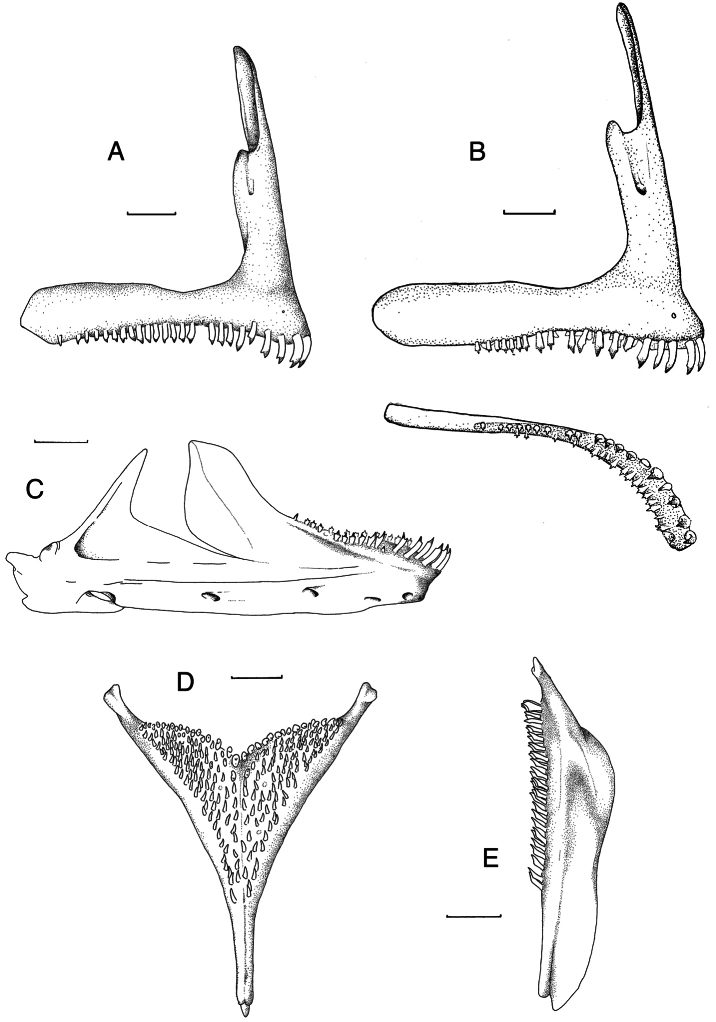
Skeletal elements of Haplochromis argens sp. n. A Right premaxilla, lateral view (RMNH.PISC.83705) B Right premaxilla, lateral (top) and occlusal (bottom) views (RMNH.PISC.83621), illustrating, for this species, a rare case of a posteriorly edentulous premaxilla C Right lower jaw, lateral view (RMNH.PISC.83697) D Lower pharyngeal element, dorsal view (RMNH.PISC. 83706) E Lower pharyngeal element, lateral view (RMNH.PISC.83706). Scale bars equal 1 mm. A, C,
D drawn by I. Westbroek, B by M. van Oijen.